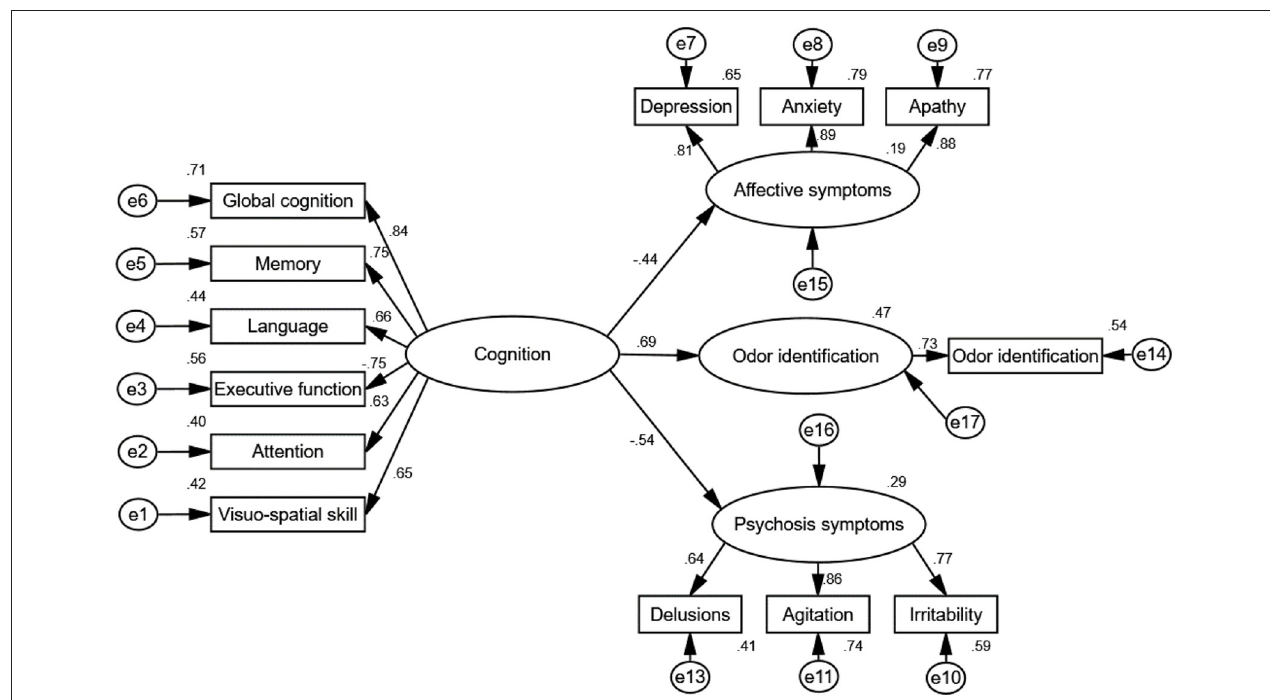
FIGURE 3 | Standardized direct effects of cognition on odor identification, affective symptoms and psychosis symptoms. The goodness-of-fit indices of the model were χ 2 / df = 1.73, GFI = 0.91, CFI = 0.96, NFI = 0.90, IFI = 0.96, and RMSEA = 0.07, indicating a good fit. The direct effect of cognition on odor identification (standardized direct effect 0.69, p < 0.01), direct effect of cognition on affective symptoms (standardized direct effect 0.44, p < 0.01), and direct effect of cognition on psychosis symptoms (standardized direct effect − 0.54, p < 0.01). All results indicate that cognition is associated with odor identification, affective symptoms and psychosis symptoms. e1–17 represent residuals of the respective